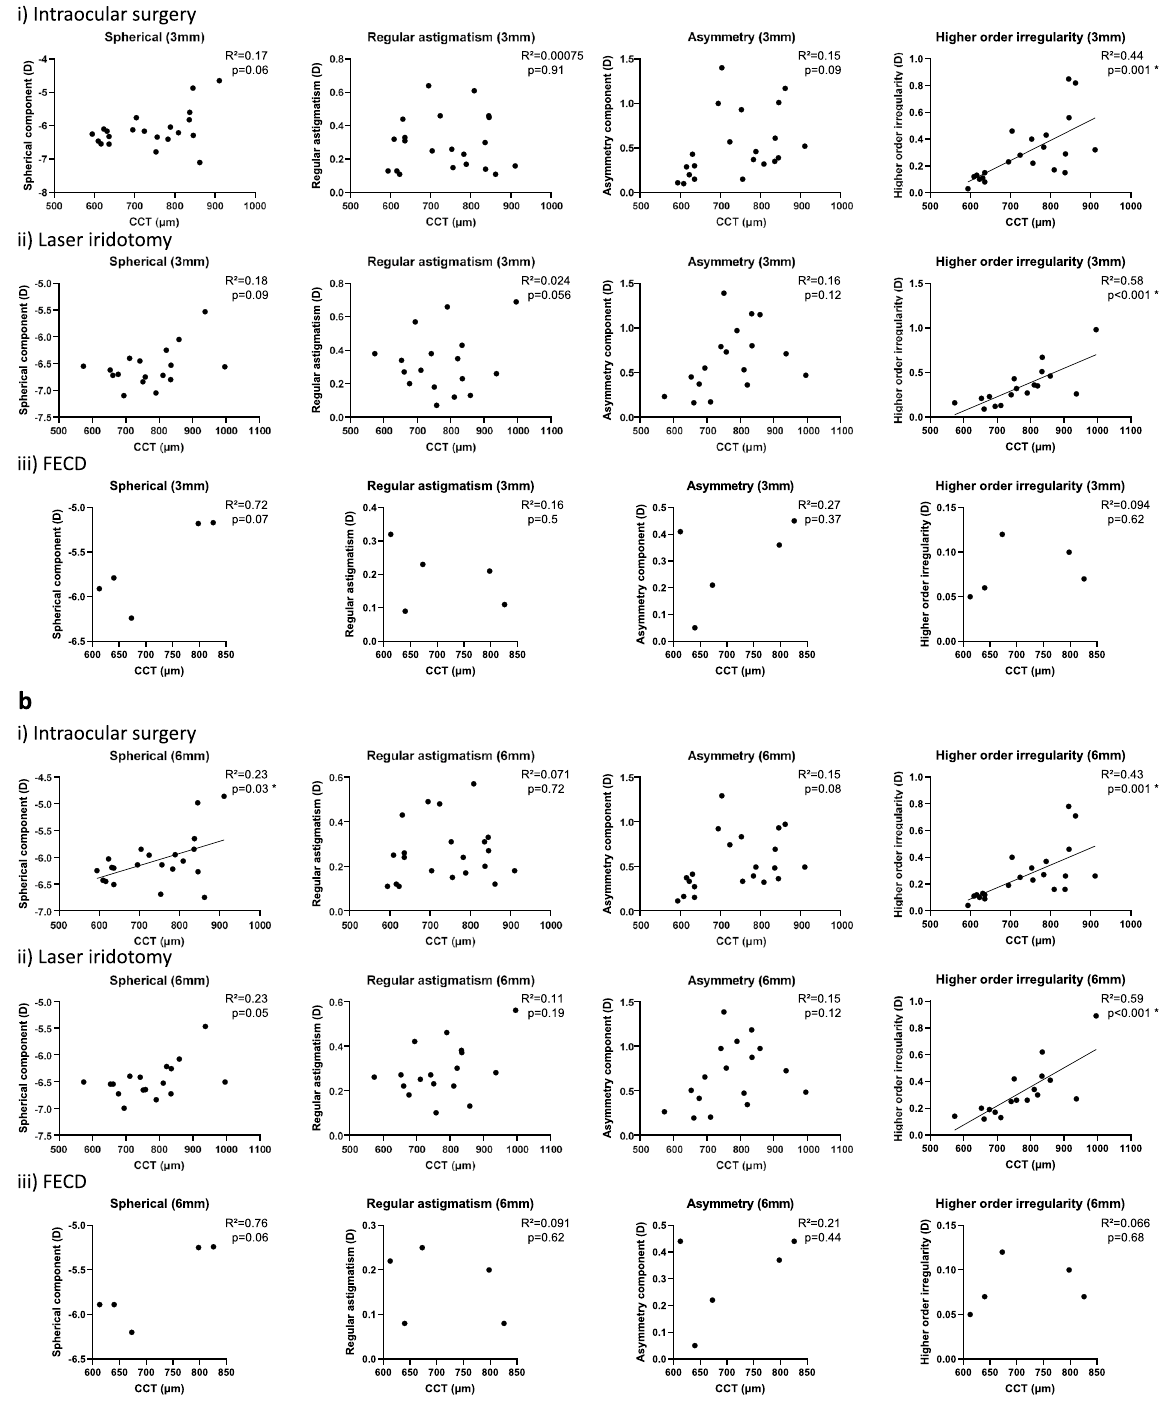
Figure 3. Subgroup analysis of the posterior cornea based on the cause of bullous keratopathy: intraocular surgery, laser iridotomy and Fuchs endothelial corneal dystrophy (FECD). Linear regression analysis is done between central corneal thickness (CCT) and each Fourier component within the central ( a ) 3 mm and ( b ) 6 mm zones. Linear regression shows significant correlations between CCT and the spherical component within the central 6 mm zone (R 2 = 0.23, p = 0.03), the higher-order irregularity within the central 3 mm zone (R 2 = 0.44, p = 0.001) and the higher-order irregularity within the central 6 mm zone (R 2 = 0.43, p = 0.001) for the intraocular surgery group. The laser iridotomy group has significant correlations between CCT and the higher- order irregularity within the central 3 mm zone (R 2 = 0.58, p < 0.001) and the central 6 mm zone (R 2 = 0.59, p < 0.001). Regression lines are drawn for graphs with statistical significance (*p <